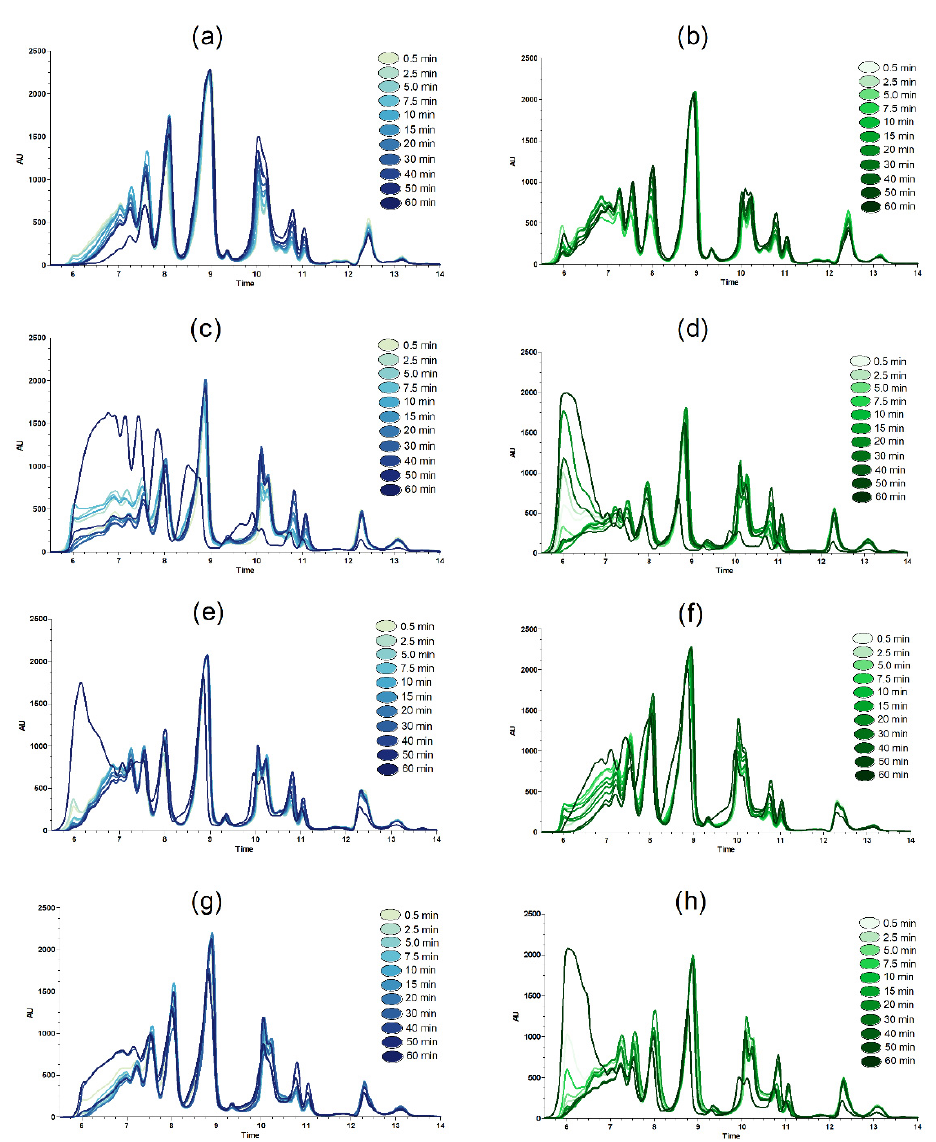
Figure 1. SEC chromatograms from time-series sampling during lab-scale hydrolysis (average of duplicate measurements) with the following materials and proteases: ( a ) CM, Bromelain, ( b ), CM, Endocut-02, ( c ), TCT, Bromelain, ( d ) TCT, Endocut-02, ( e ) TCT+CM, Bromelain, ( f ) TCT+CM, Endocut-02, ( g ) MDCR, Bromelain, ( h ) MDCR, Endocut-02. The time series colors are given in the